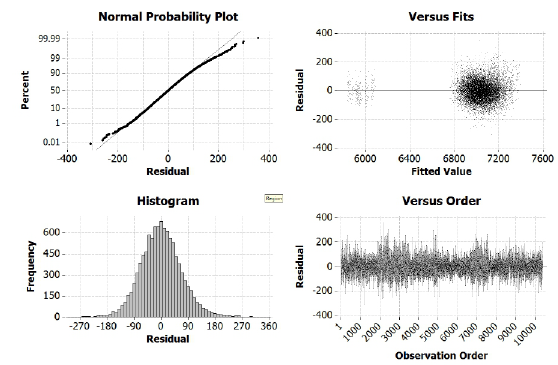
Figure 6. Properties of the residuals (mm). SE = 66.99 mm. Dif- ferent depiction of the residuals all suggests homoge- neous(homoscedastic) and nearly Gaussian random dis- tribution.